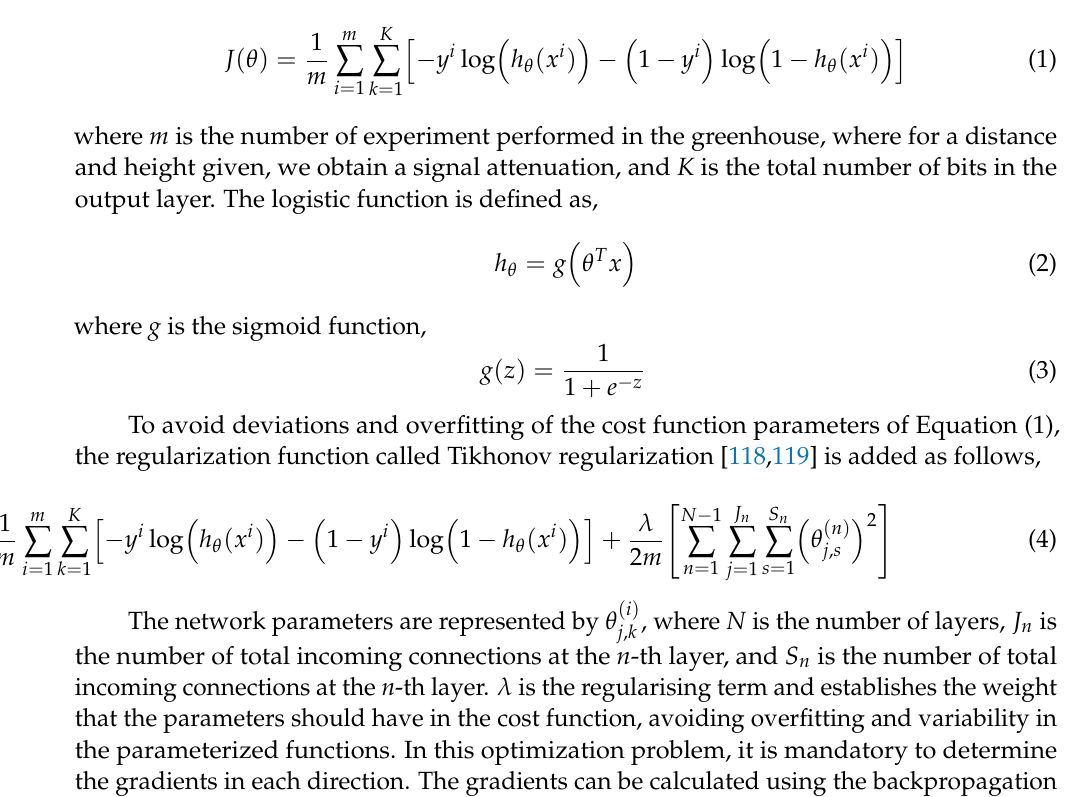
Figure 4. Representation of distance and height, which is composed the vector X, while the estimated attenuation values L foliage ( d , h ) or measured dB are composed of Y. The B values are bits that can take the values either 0 or 1. Then, for creating the real number, the distance, height, and L foliage (d,h) have a integer part and decimal part.